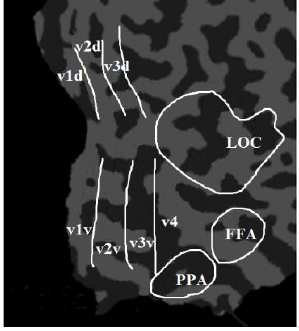
Figure 2. The eleven ROIs of the proposed algorithm, including V1d, V1v, V2d, V2v, V3d, V3v, V4, LOC, FFA, and PPA.